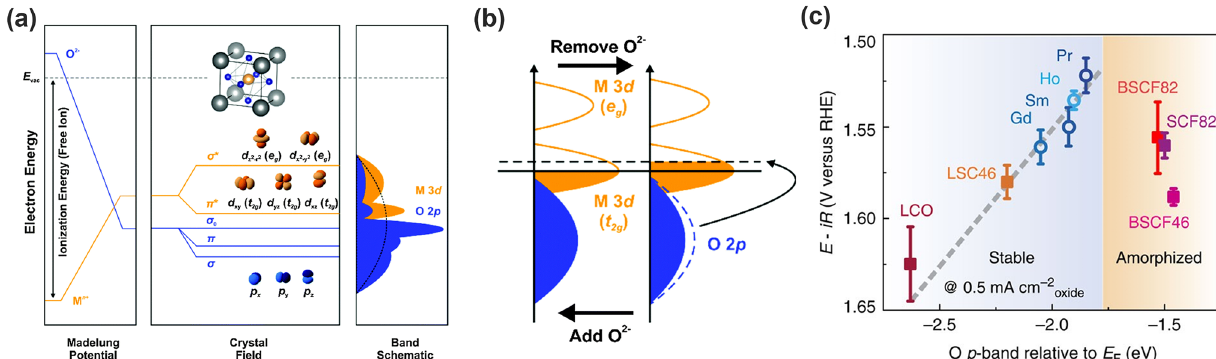
Fig. 5 Bulk O 2 p -band center relative to Fermi level ( ε O-2p ) as a descriptor for OER. a Physical origin of shifts in constituent ion orbitals for oxides with octahedral oxygen coordination around transition metal ions. The dashed line represents the energy of free vacuum. b Schematic illustration of the density of states of perovskite oxides, showing the transition metal 3 d and O 2 p bands [51]. Copyright © 2015 Royal Chemical Society. c Correlation between the iR-corrected potential at 0.5 mA cm −2 and the ε O-2p (eV) of (Ln 0.5 Ba 0.5 )CoO 3− δ with Ln = Pr, Sm, Gd and Ho [4]. Copyright © 2013 Springer